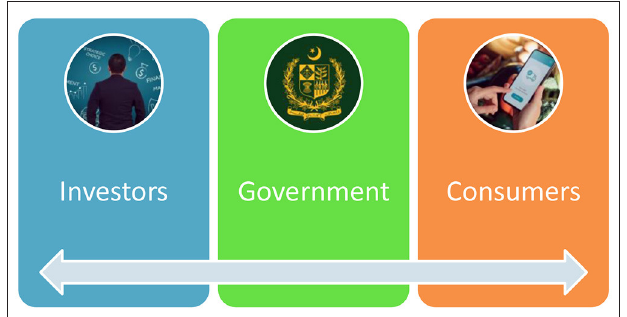
FIGURE 4 | CPEC digitalization and transformation correlation.